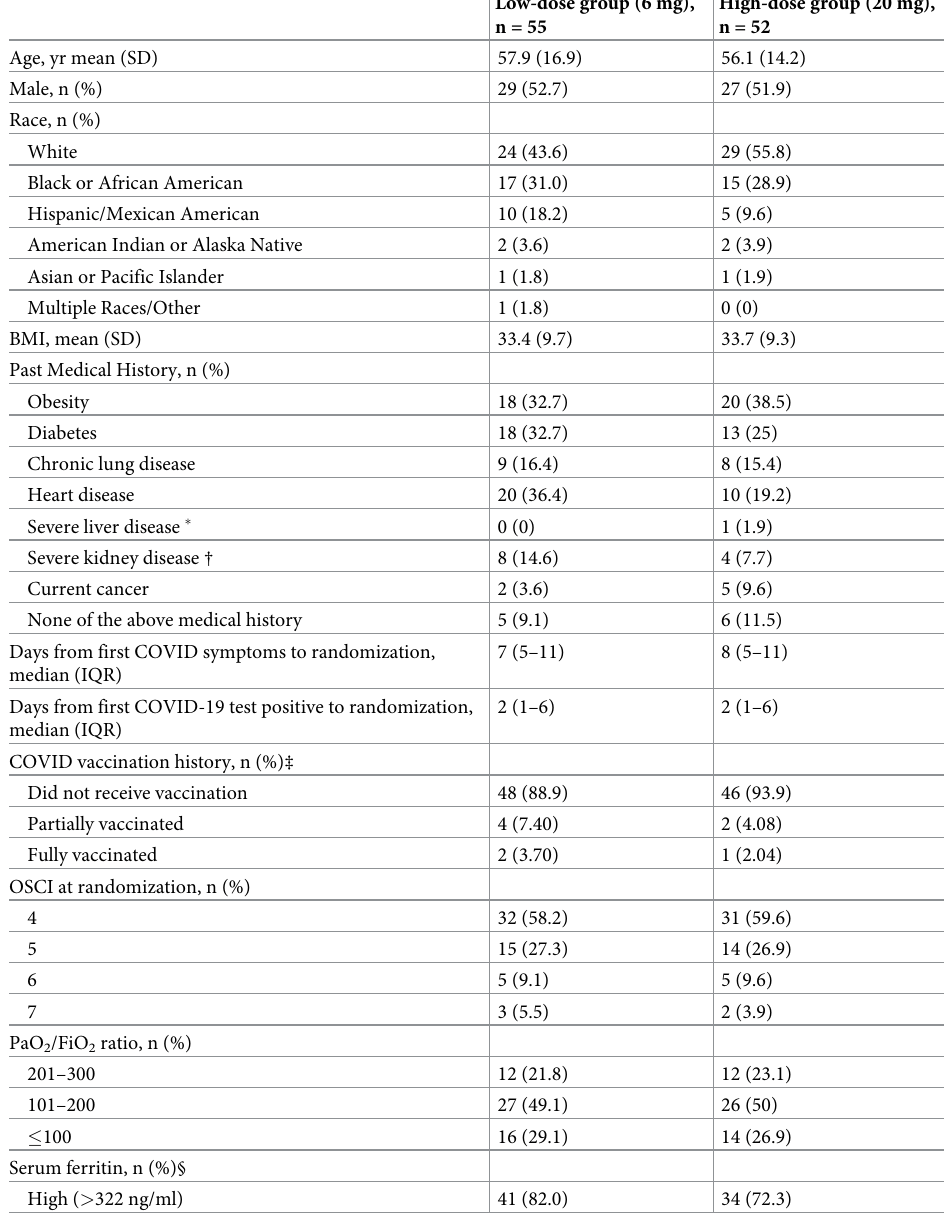
Table 1. Basic characteristics of study patients by dexamethasone dose